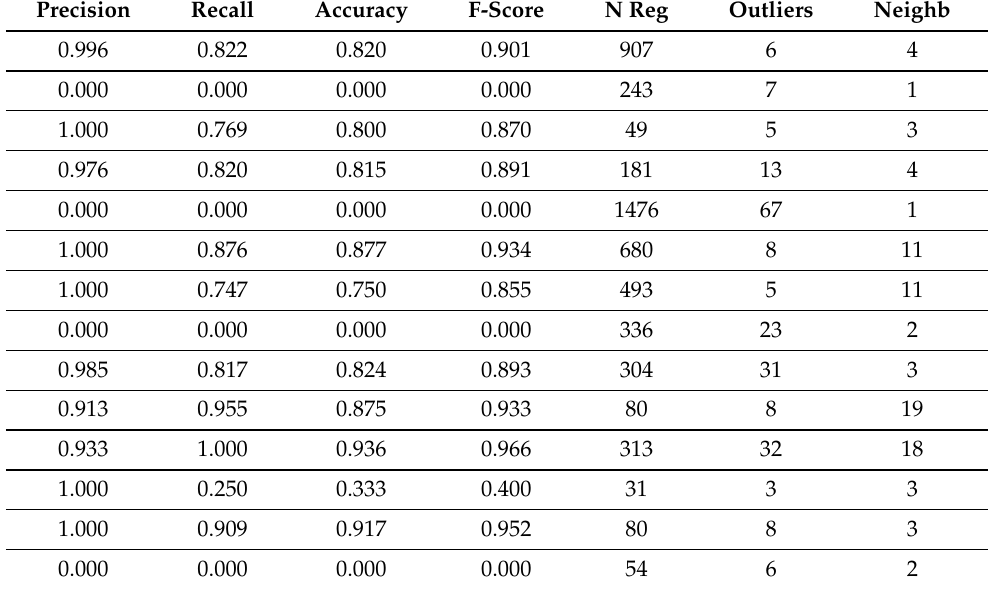
Table 2. Precision and Recall values for